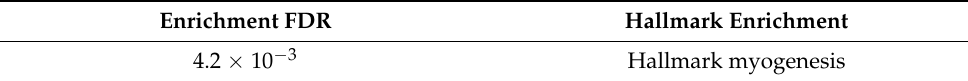
Table 6. The top pathways for strong A 2A R expression obtained by Hallmark enrichment in TCGA astrocytoma patients.